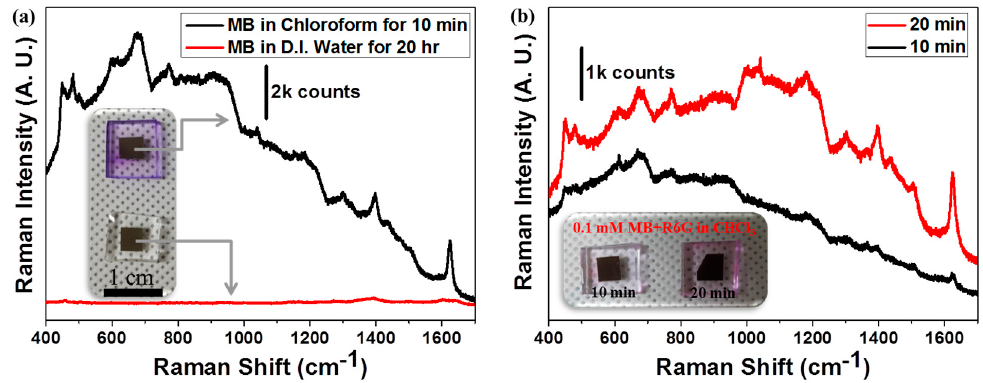
Figure 4. Nanofiltration-membrane-encapsulated SERS substrates that permitted the selective permeation of molecules. ( a ) Molecules infiltrated the encapsulated SERS substrate based on the degree of PDMS swelling in different solvents. PDMS swelled in contact with nonpolar chloroform, whereas it did not swell in polar water. Therefore, methylene blue (MB) molecules dissolved in chloroform could diffuse into the PDMS polymer network and toward hotspot regions of the SERS substrate. As time passed, the PDMS-encapsulated device soaked in chloroform turned blue due to MB infusion, whereas the PDMS-encapsulated device soaked in water maintained its transparency, even after a 20 h incubation period (inset). ( b ) Selective permeation based on molecular size. The encapsulated SERS substrate was soaked in MB- or rhodamine 6G (R6G)-containing chloroform solutions. Only the MB SERS spectrum was observed. The small MB (MW = 319.85 g/mol) molecules alone could diffuse into the PDMS membrane, and the large rhodamine 6G (MW = 497.02 g/mol) molecules were excluded.